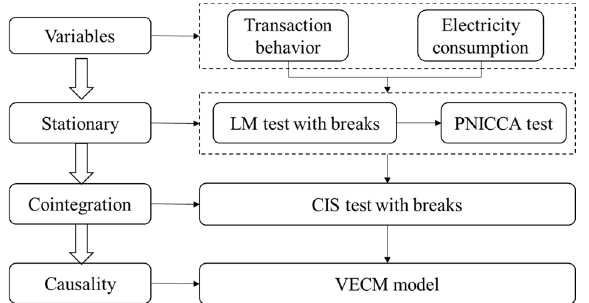
Fig. 1 the empirical process in this